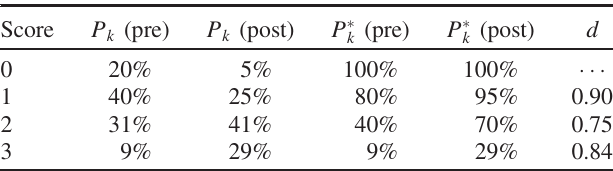
TABLE IV. Example of the calculation of the effect sizes for partial scores between 0 and